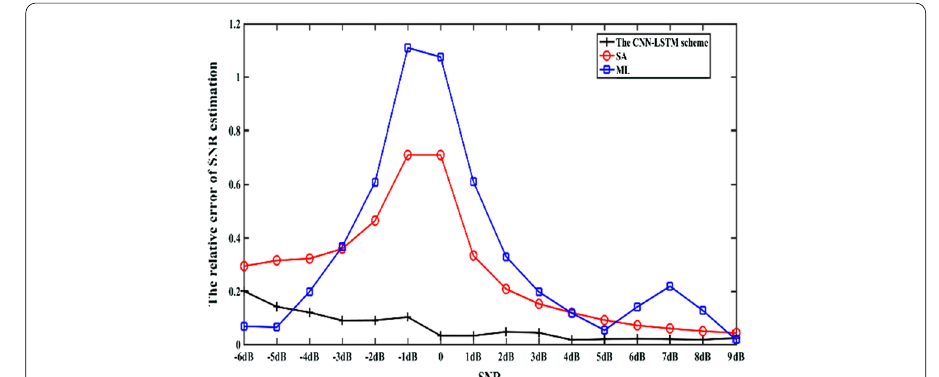
Fig. 3 Relative error comparisons of various SNR estimation